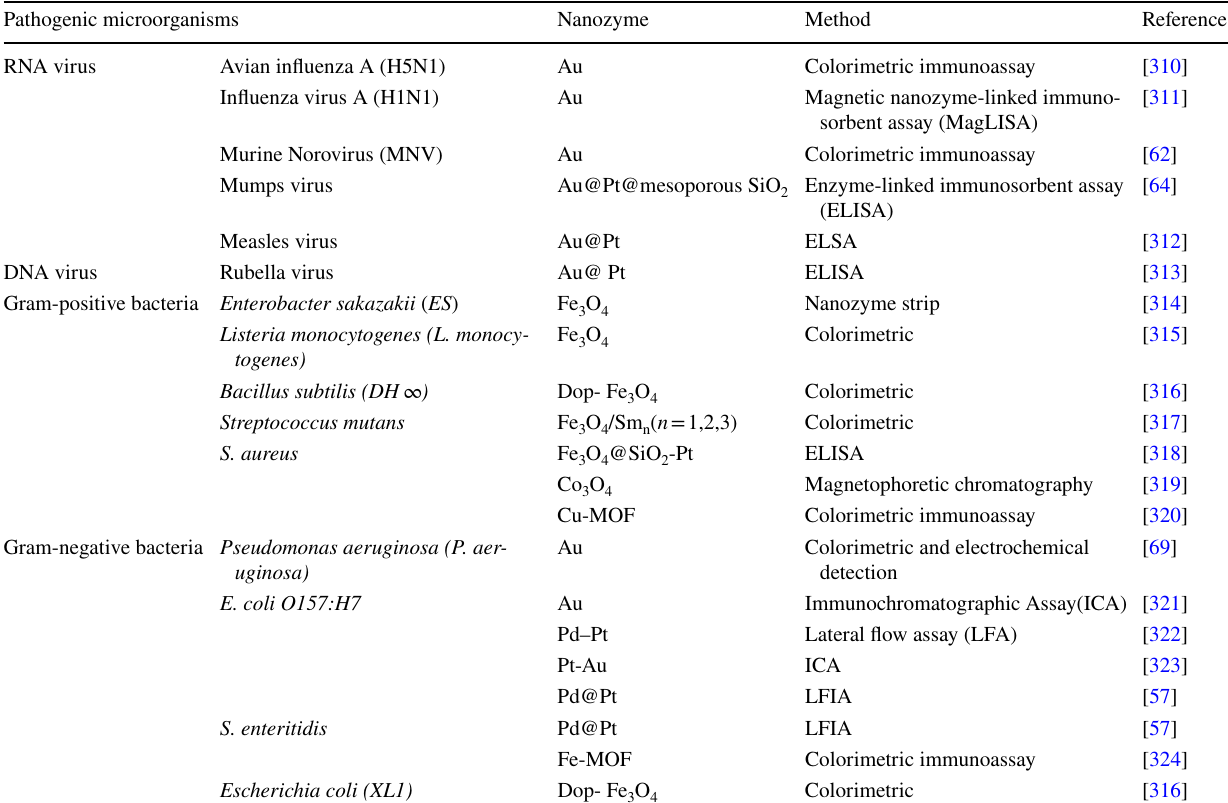
Table 2 Nanozyme and analysis method for pathogen microorganism detection reported in recent years Pathogenic microorganisms Nanozyme